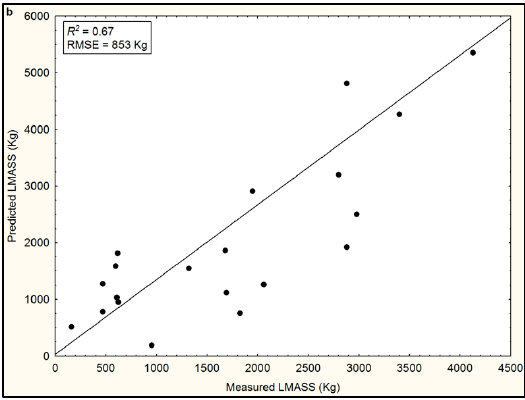
Figure 5. (b) Performance of the PLS models in predicting LMASS on the independent test dataset